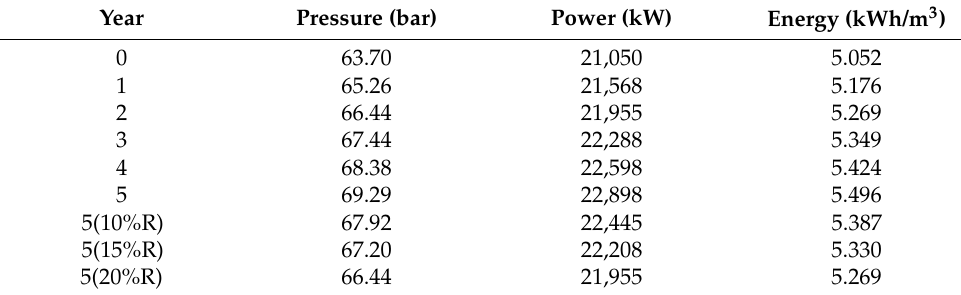
Table 3. Pressure, Power, and Energy consumption at 27 ◦